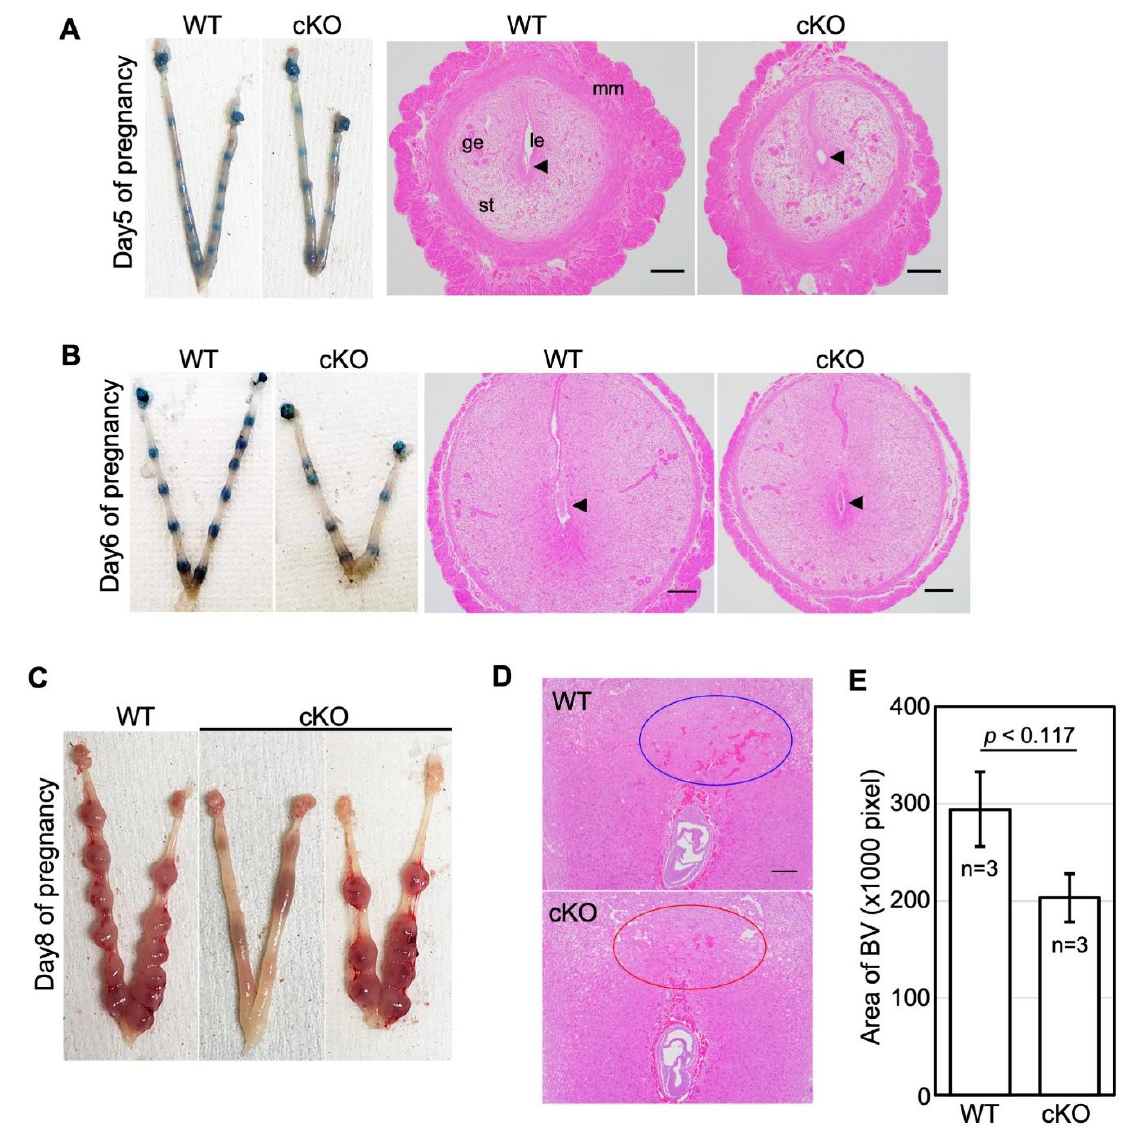
Figure 2. The miscarriage rate is increased in cKO mice after implantation. ( A , B ) Representative of uteri and HE-stained section of implantation sites from WT and cKO on days 5 ( A ) and 6 ( B ) of pregnancy. ( C ) Representative of uteri of WT and cKO on day 8. ( D ) HE-stained section of implantation sites and area of the blood vessel (BV) on day 8. ( E ) Although the difference is not significant, the calculated pixel areas of the blood vessel cavities in the mesometrial region in the cKO seem decreased compared to those in WT. The scale bar shows 100 µm. Arrowheads show embryo. Circles show uterine vessels in the mesometrial region. le, luminal epithelium; ge, glandular epithelium; st, endometrial stroma; mm, myometrium.